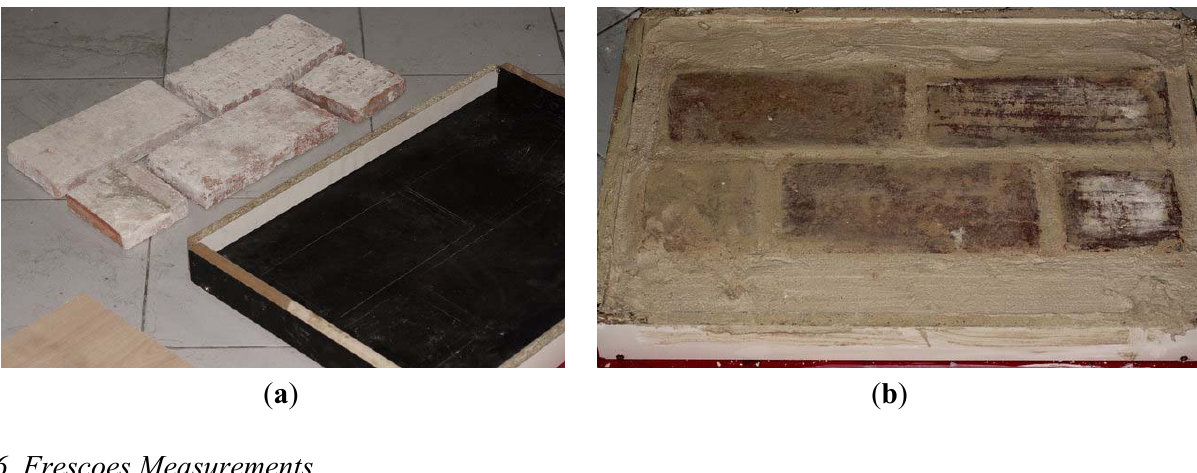
Figure 4. Test specimen preparation: ( a ) positioning of the bricks with a joint of 2 cm; ( b ) Coating with lime and sand